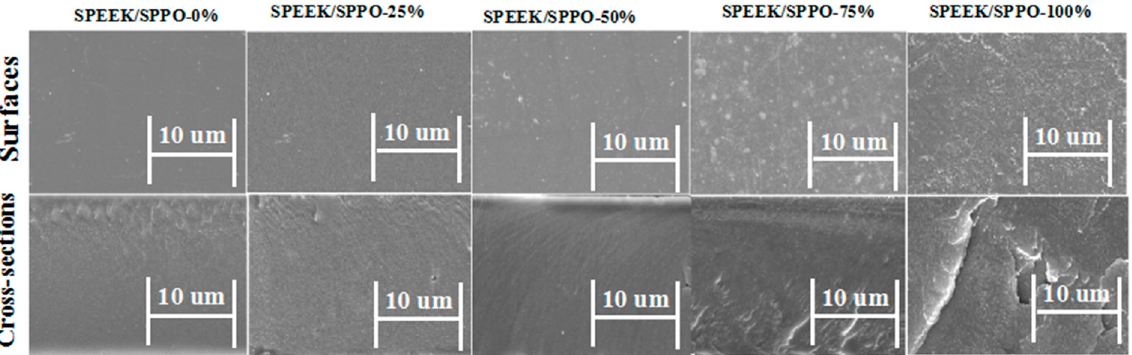
Figure 3. SEM images of surfaces and cross-sections of the membranes SPEEK/SPPO-0 to SPEEK/SPPO-100 (where 0, 25, 50, 75 and 100% represent the amount of SPPO into the SPEEK/SPPO blended membranes).